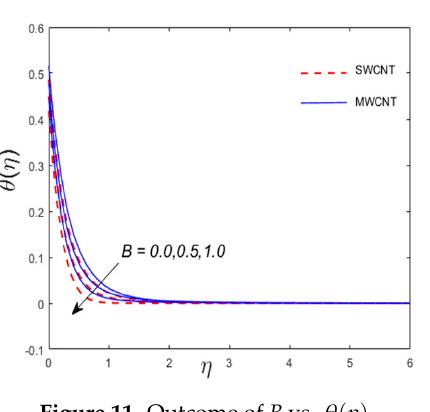
B θη vs. ( ) . B θη vs. ( ) .